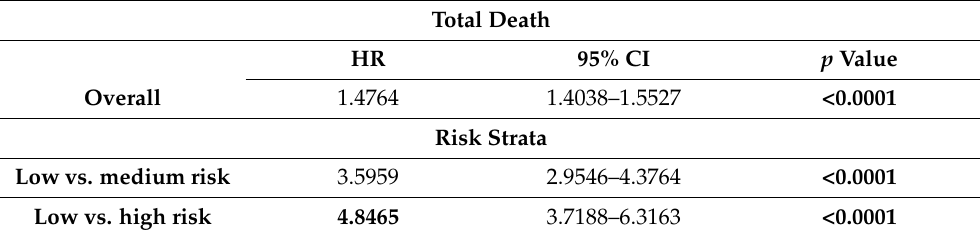
Table 9. Total all-cause-death hazard ratios for C 2 HEST risk stratification in non-CAD cohort.